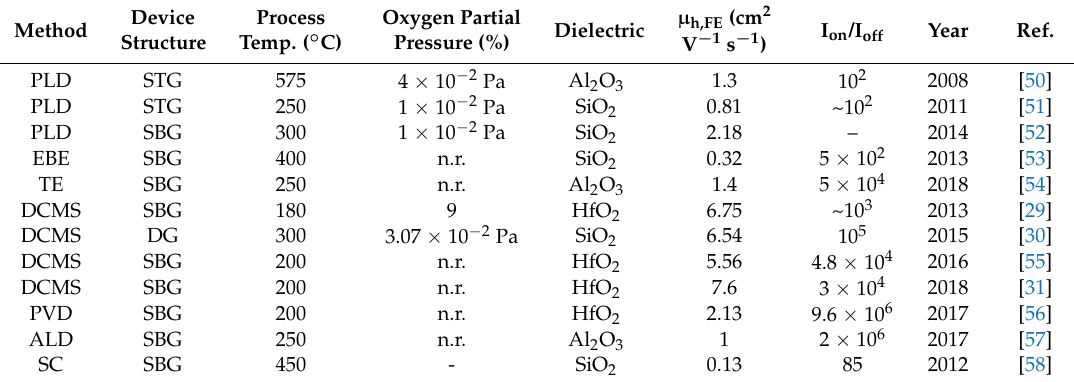
Table 2. Recent developments concerning the performances of p-type SnO TFTs processed by other physical and chemical process techniques, for different device configurations, O pp , dielectrics and process